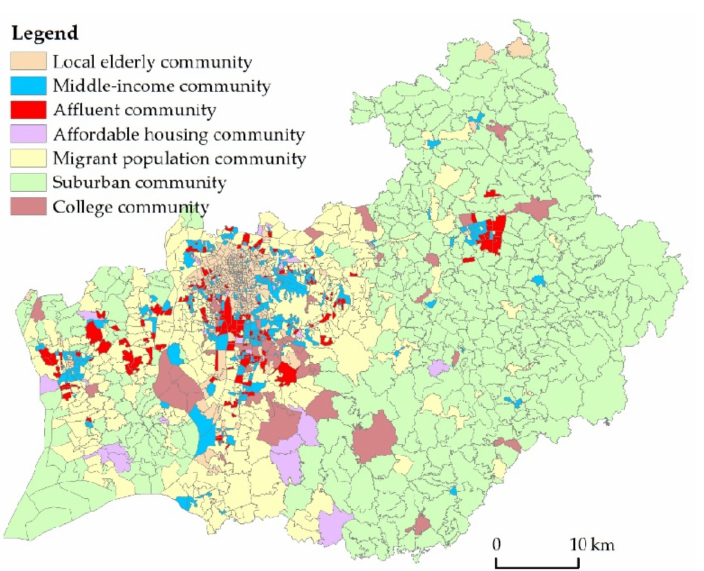
Figure 2. The distribution of different categories of communities in ZG